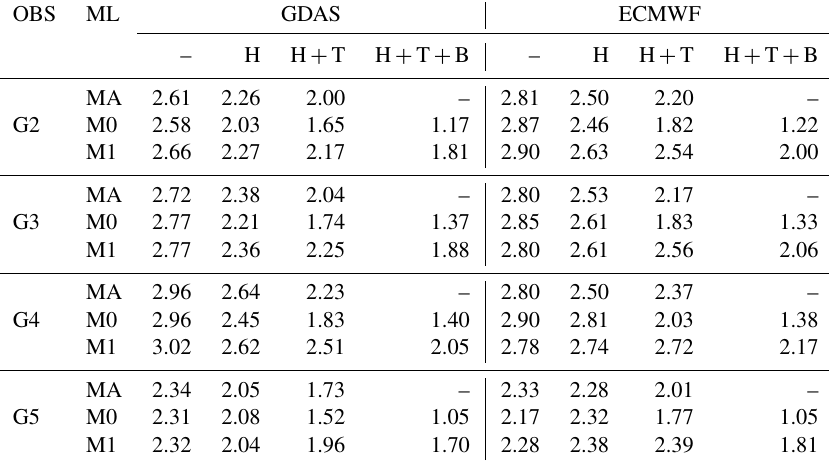
Table 4. Ranks of the inverse tests with various extra constraints evaluated against the G2, G3, G4, and G5 observations (OBS). For mass loading (ML), MA is integrating from the surface to the cloud top; M0 is calculated for a single layer where the cloud top height resides; and M1 is integrating over three layers centered at the cloud top layer. For extra zero observation constraints, H is with clear pixels; T is with a clear column above the ash cloud; and B is with a clear column below the ash cloud. Ash cells are assimilated in all inverse cases. The satellite data at both G1 and G2 are used for all cases listed